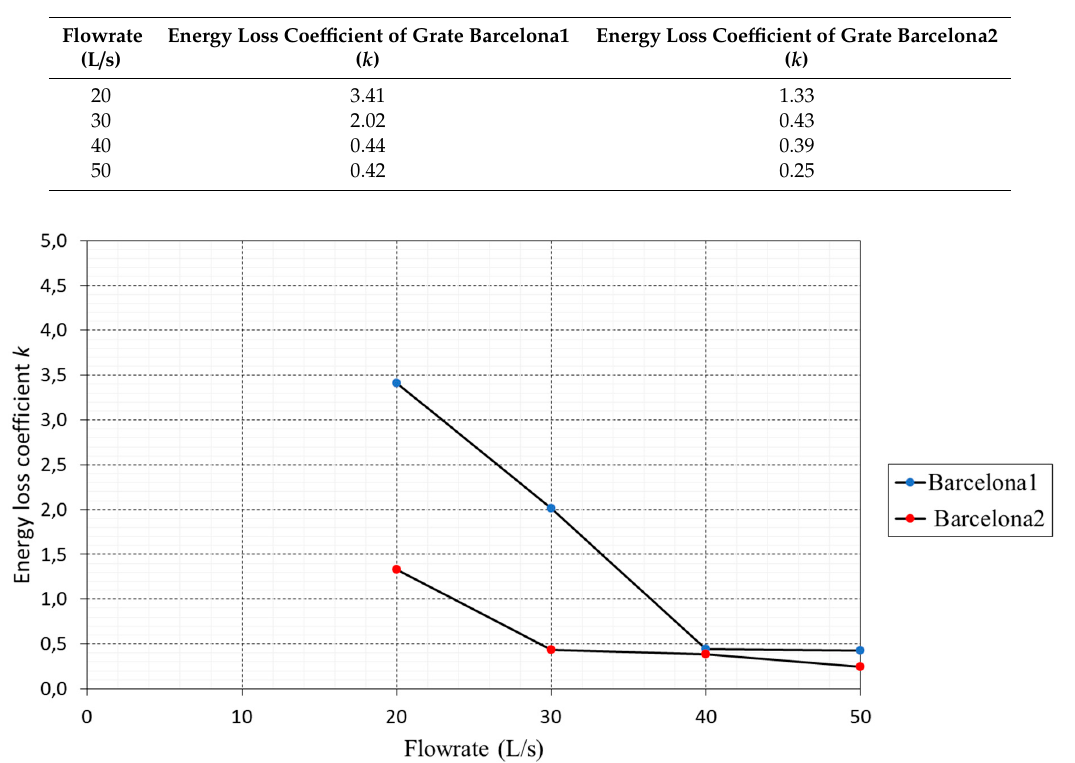
Figure 7. Graph of energy loss coefficient k of grate Barcelona2. Table 3. Energy loss coefficient k for the tested grates.